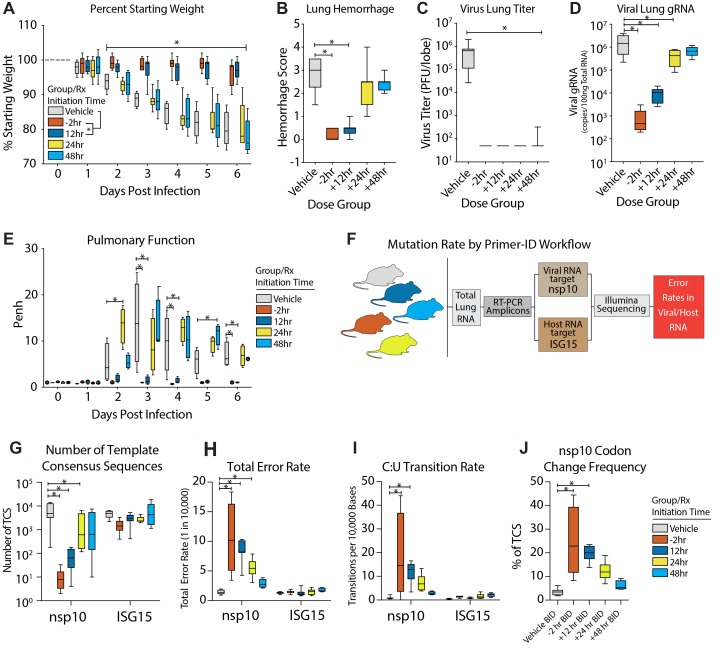
Prophylactic and therapeutic EIDD-2801 reduces MERS-CoV replication and
pathogenesis coincident with increased viral mutation rates. Equivalent
numbers of 10-14 week old male and female C57BL/6 hDPP4 mice were administered vehicle
(10% PEG, 2.5% Cremophor RH40 in water) or NHC prodrug EIDD-2801 beginning at -2
hours, +12, +24 or +48 hours post infection and every 12 hours thereafter by oral
gavage (n = 10/group). Mice were intranasally infected with 5E+04 PFU mouse-adapted
MERS-CoV M35C4 strain. (A) Percent starting weight. Asterisks indicate
differences between -2 hours and +12 hours group from vehicle by two-way ANOVA with
Tukey’s multiple comparison test. (B) Lung hemorrhage in mice from
panel A scored on a scale of 0-4 where 0 is a normal pink healthy lung
and 4 is a diffusely discolored dark red lung. (C) Virus lung titer in
mice from panel A as determined by plaque assay. Asterisks in both panel
B and C indicate differences from vehicle by
Kruskal-Wallis with Dunn’s multiple comparison test. (D) MERS-CoV
genomic RNA in lung tissue by qRT-PCR. Asterisks indicate differences by one-way ANOVA
with a Dunnett’s multiple comparison test. (E) Pulmonary function
by whole body plethysmography was performed daily on four animals per group. Asterisks
indicate differences from vehicle by two-way ANOVA with Tukey’s multiple
comparison test. (F) Workflow to measure mutation rate in MERS-CoV RNA
and host transcript ISG15 by Primer ID in mouse lung tissue. (G) Number
of template consensus sequences (TCS) for MERS-CoV nsp10 and ISG15. (H)
Total error rate in MERS-CoV nsp10 and ISG15. (I) The cytosine to uridine
transition rate in MERS-CoV nsp10 and ISG15. In panels G-I, asterisks
indicate differences from vehicle by two-way ANOVA with Tukey’s multiple
comparison test. (J) Codon change frequency in MERS-CoV nsp10. Asterisks
indicate differences from vehicle by Kruskal-Wallis with Dunn’s multiple
comparison test. For all panels, the boxes encompass the 25th to 75th percentile, the
line is at the median, while the whiskers represent the range.